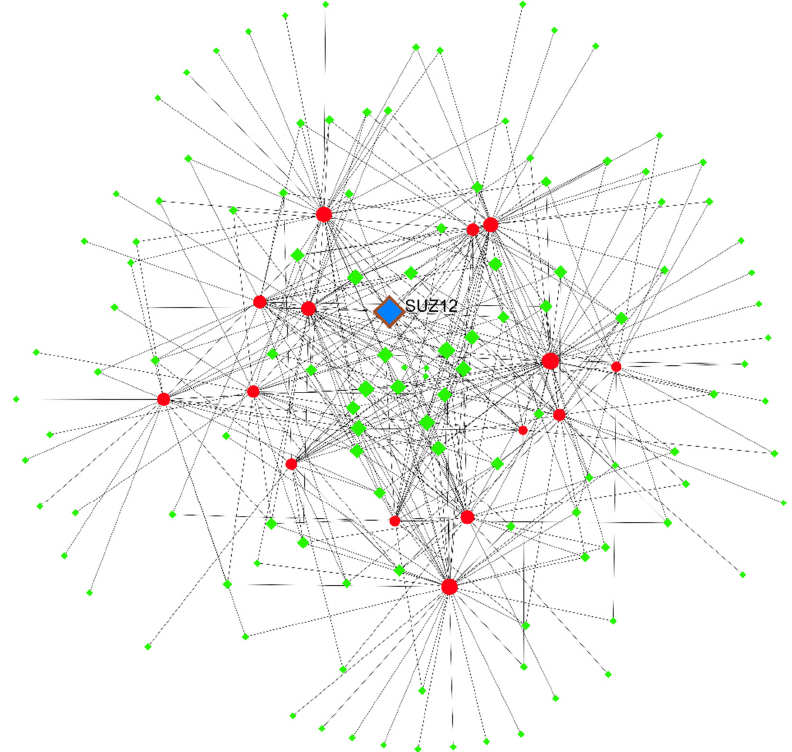
Figure 17. The network of TF-hub genes. Circles show the hub gene, while the diamonds represent TFs targeting the hub genes.